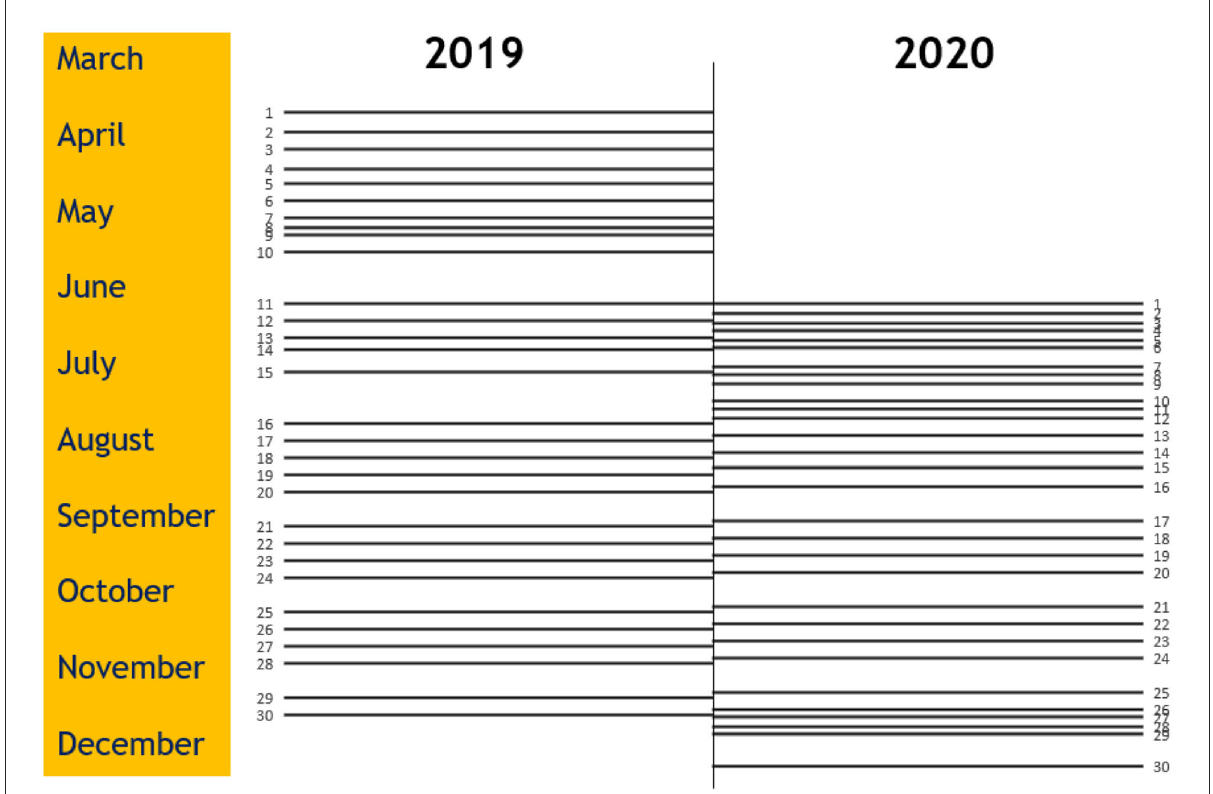
FIGURE1 Distribution of matches in the Norwegian male premier league in the 2019 and 2020 seasons. One line represents the main match day for each round. The number represents the game week